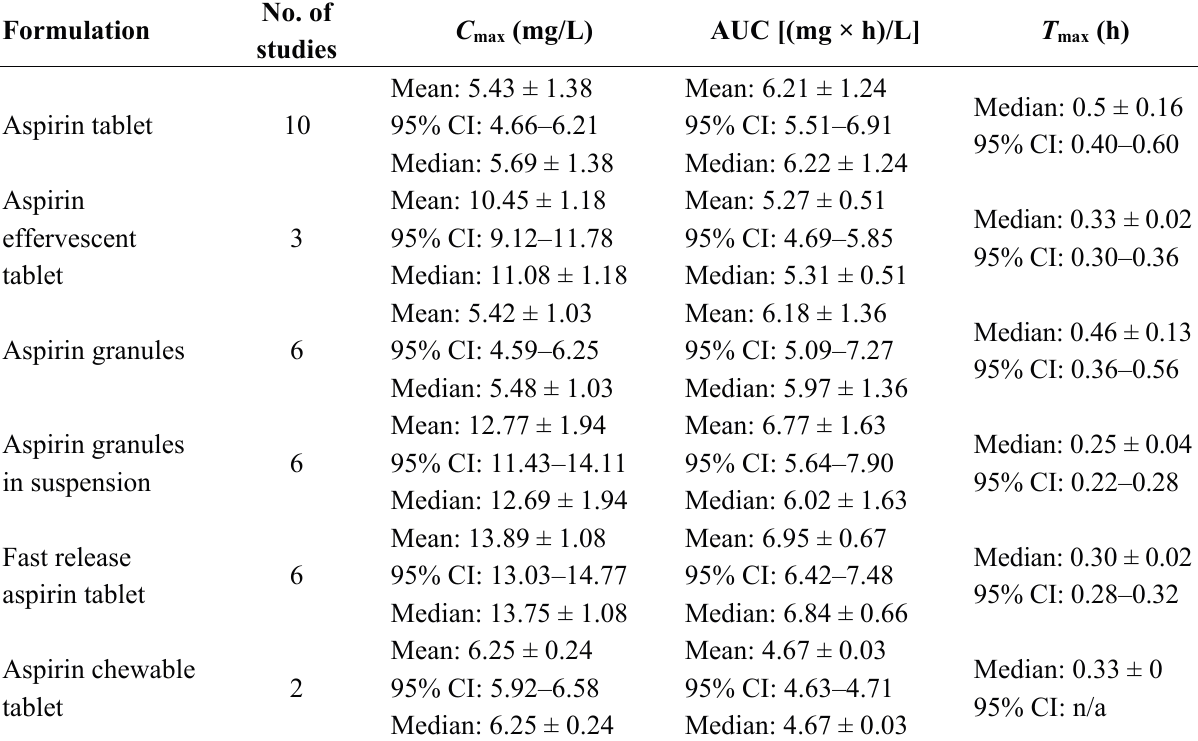
Table 1. Summary pharmacokinetic data of acetylsalicylic acid for aspirin formulations. Formulation